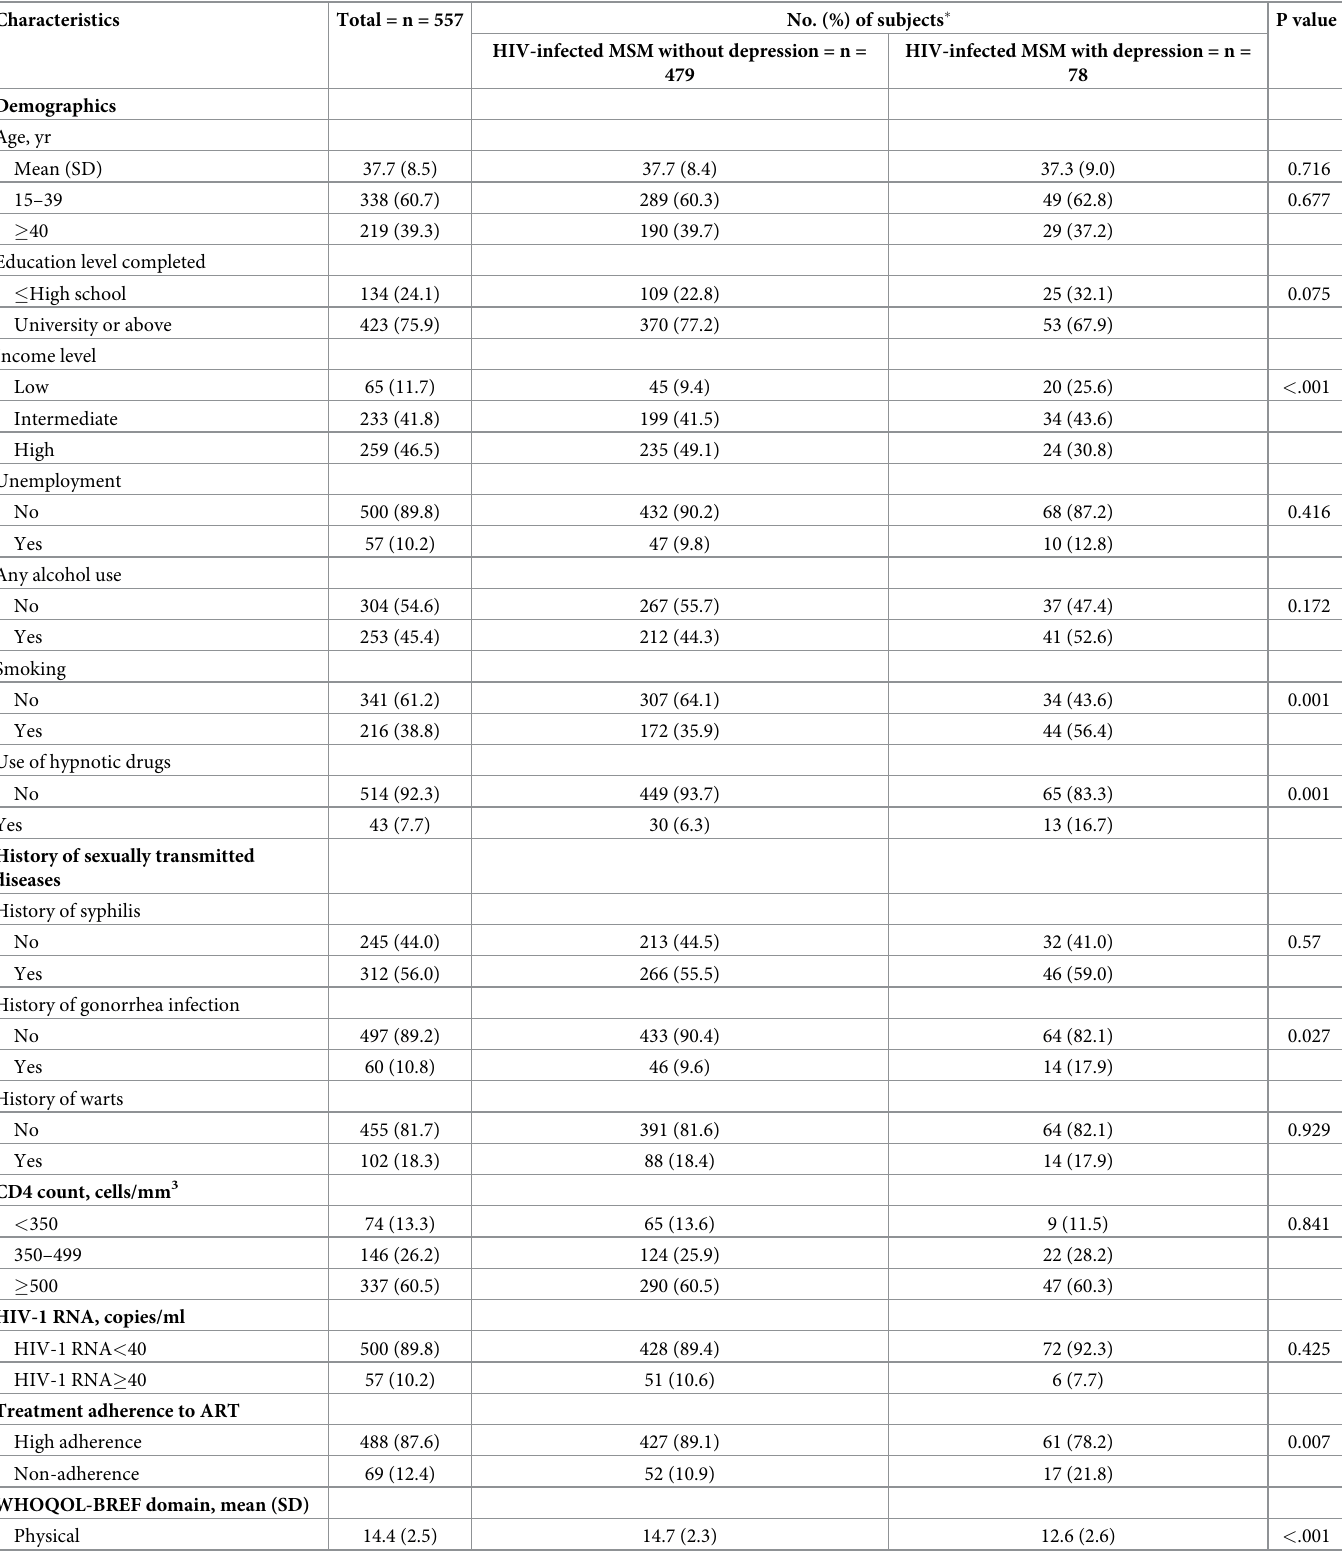
Table 1. Characteristics of the HIV-infected MSM, by depression status.